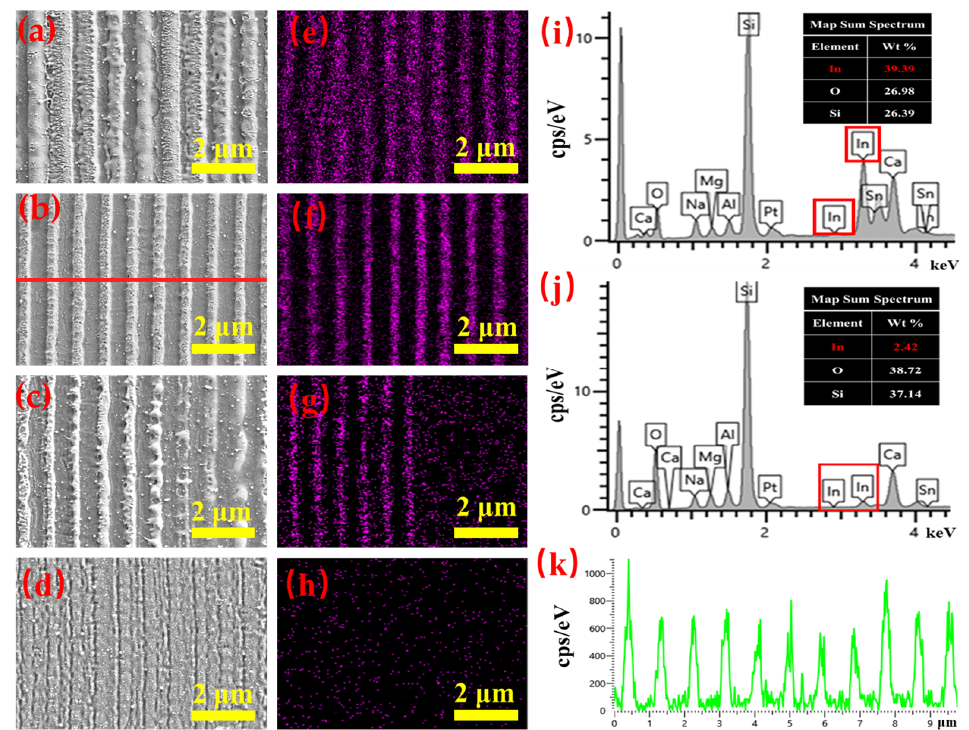
Figure 9. SEM images of LSFLs on the ITO film after laser irradiation under scanning velocities of ( a ) 4, ( b ) 3, ( c ) 2 and ( d ) 1 mm/s with fixed pulse fluence of 0.66 J/cm 2 . ( e – h ) Distributions of indium ion content measured by EDS corresponding to ( a – d ) respectively. The scale bars are all 2 µm. ( i ) and ( j ) are the sum spectra of ( a , d ), respectively. ( k ) is the distribution of the indium content along the red line in ( b ).